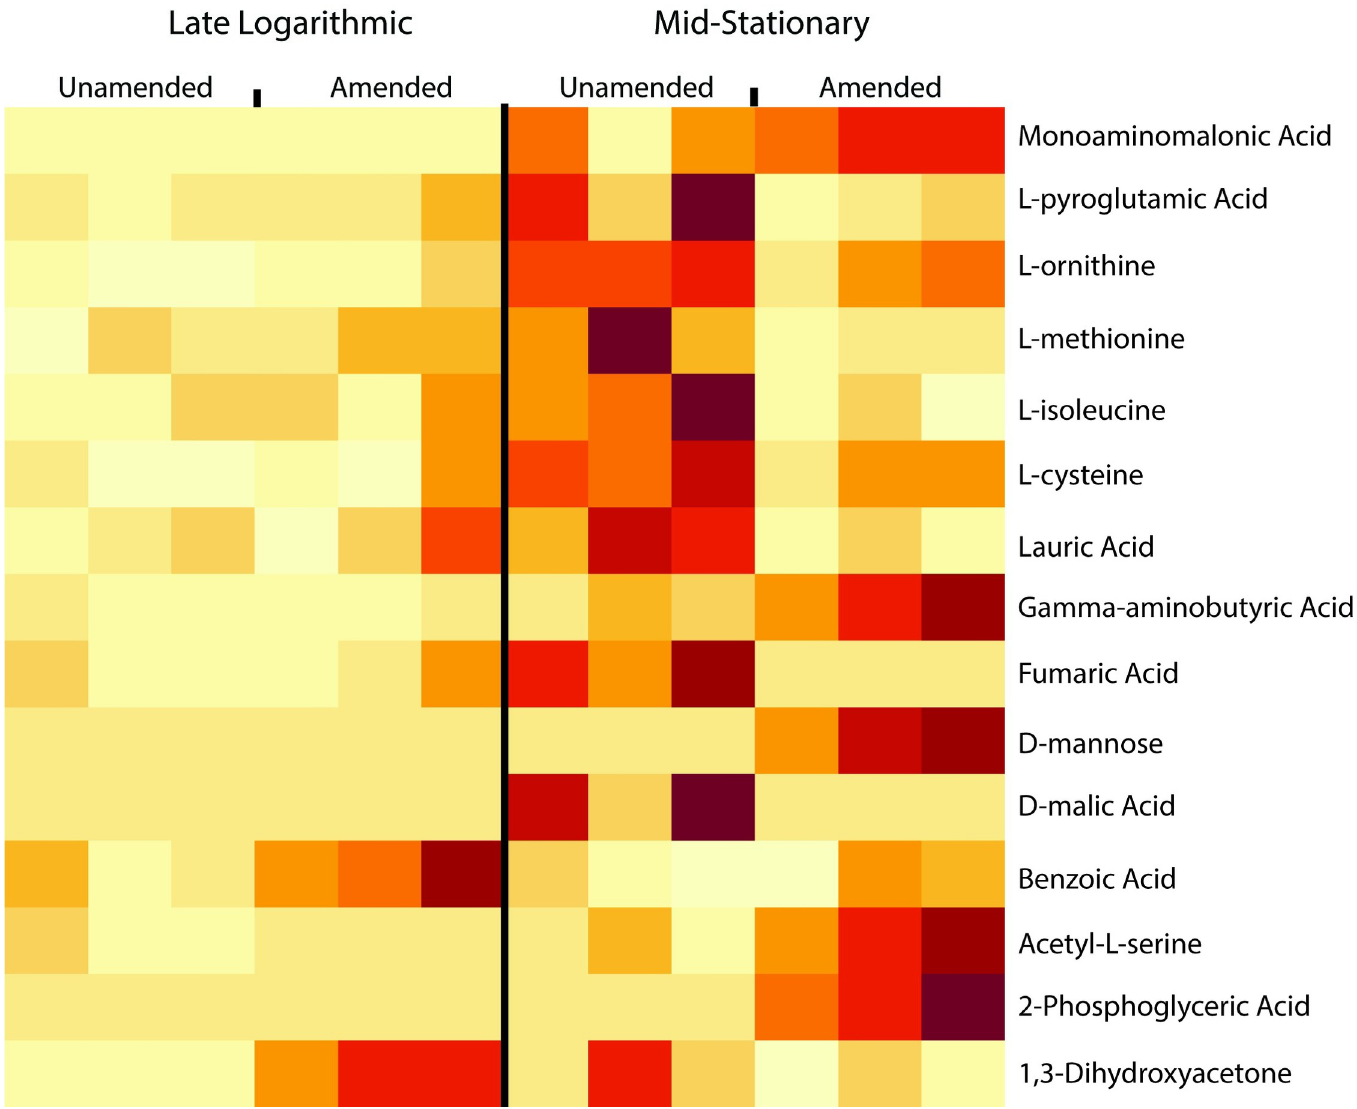
Fig 3. Heat map of indicator metabolites in lignin-amended and unamended cultures for both late logarithmic and mid-stationary phase.